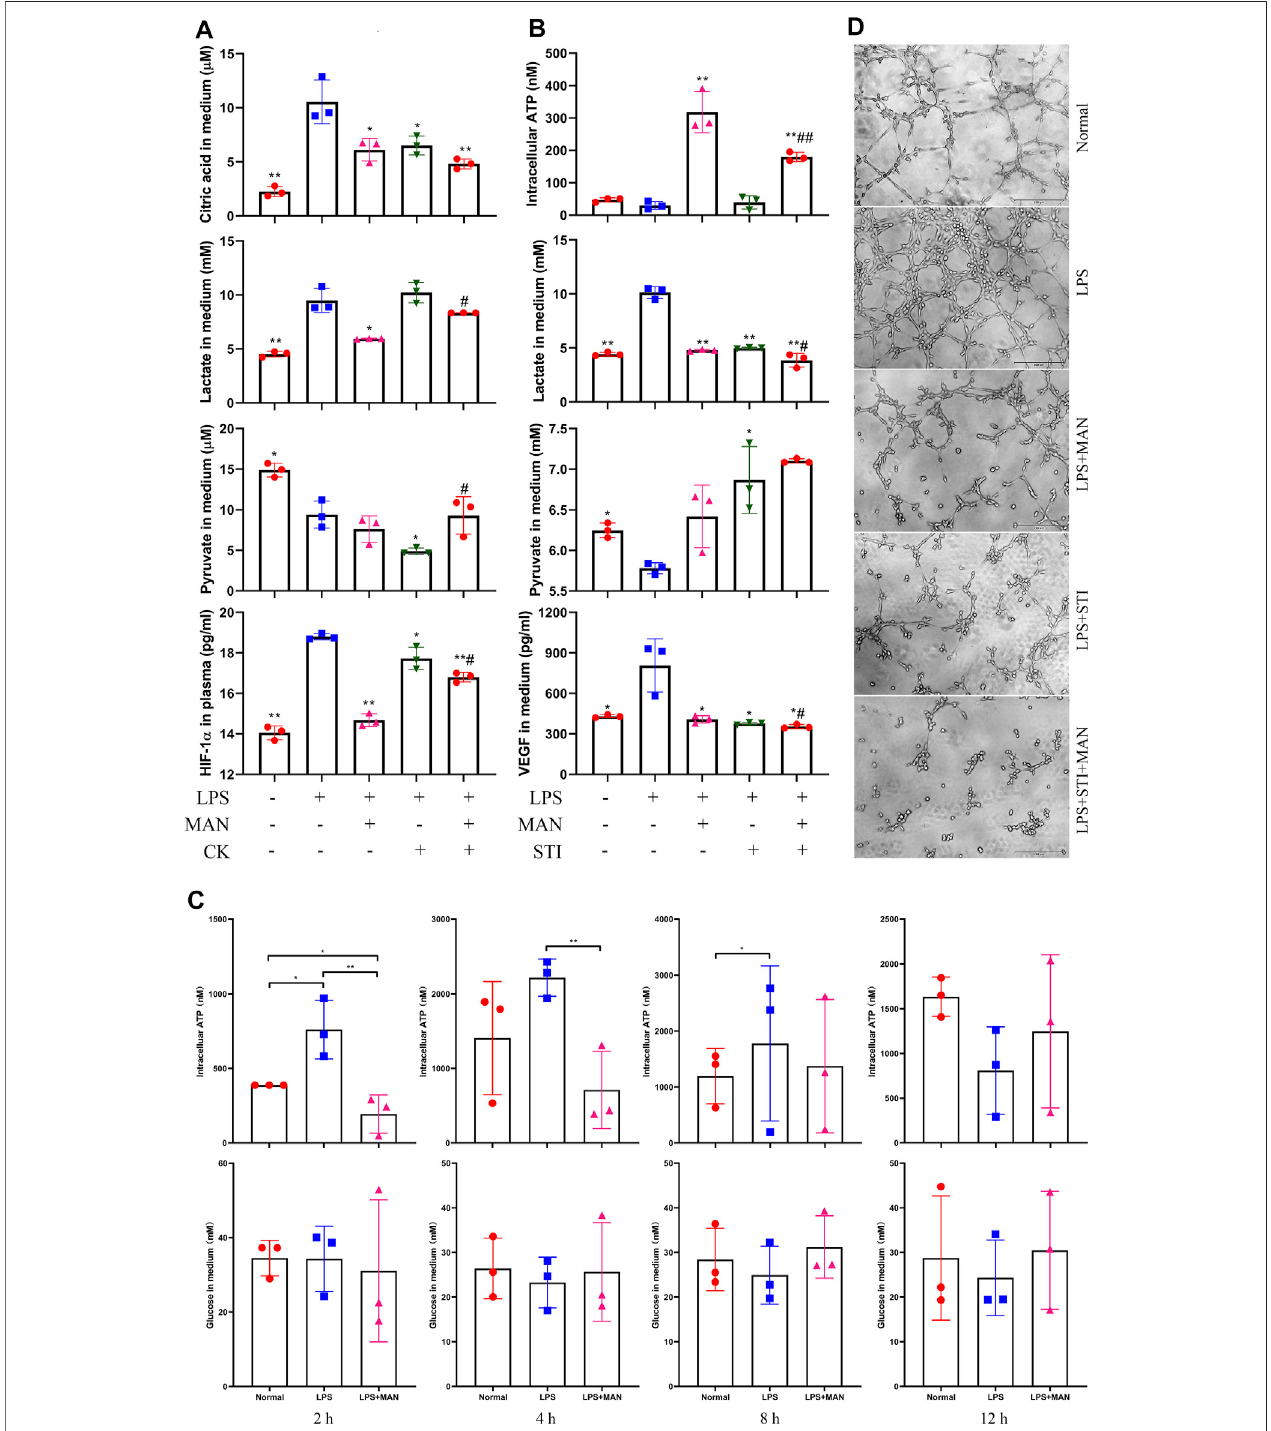
FIGURE 8 | Inhibition of MAN on in fl ammation-caused aerobic glycolysis contributed to its anti-angiogenesis properties. (A) , levels of citric acid, lactate, pyruvate and HIF-1 α in culture medium from LPS-primed HUVECs receiving PKM2 inhibitor CK or/plus MAN stimulus ( n (cid:2) 3); (B) , levels of lactate, pyruvate and VEGF in culture medium as well as intracellular ATP of LPS-primed HUVECs receiving LDH inhibitor STI or/plus MAN stimulus ( n (cid:2) 3); (C) , dynamic changes of intracellular ATP and extracellular glucose in HUVECs culture system in the presence of LPS or LPS + MAN ( n (cid:2) 3); D, STI and MAN exerted similar and synergistic effects on tube- forming capability of LPS-primed HUVECs in vitro . Statistical signi fi cance in image A and B: * p < 0.05 and ** p < 0.01 compared with LPS-primed cells; # p < 0.05 and ## p < 0.01 compared with cells receiving LPS + MAN treatment.